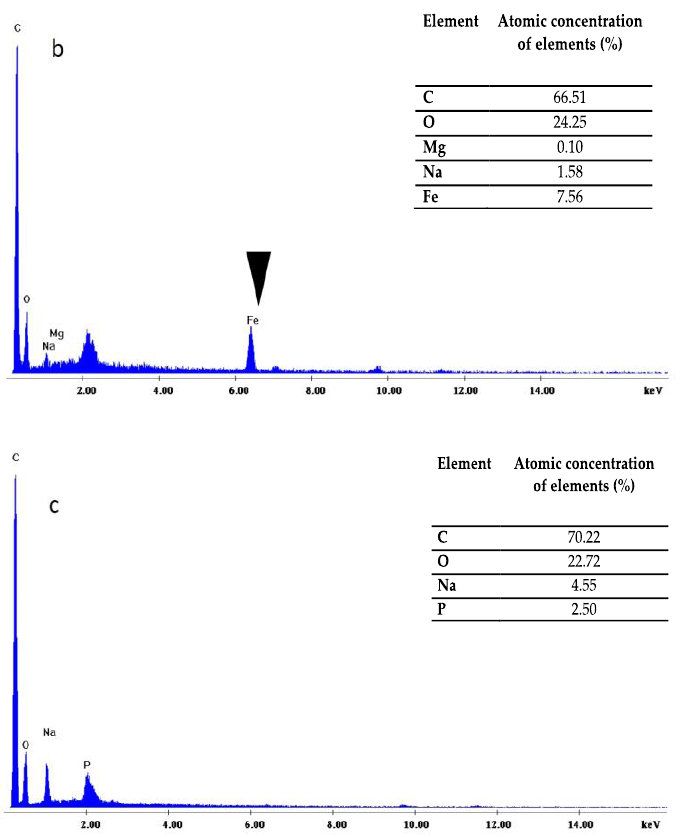
Figure 7. EDX analysis for the detection of the elemental composition of the substance. ( a ) EDX analysis of digested and transformed cells where the iron peak (arrow) is visible. ( b ) EDX analysis of glass bead-treated and transformed cells where the iron peak (arrow) is visible. ( c ) EDX analysis of control cells where the iron peak is not detected.